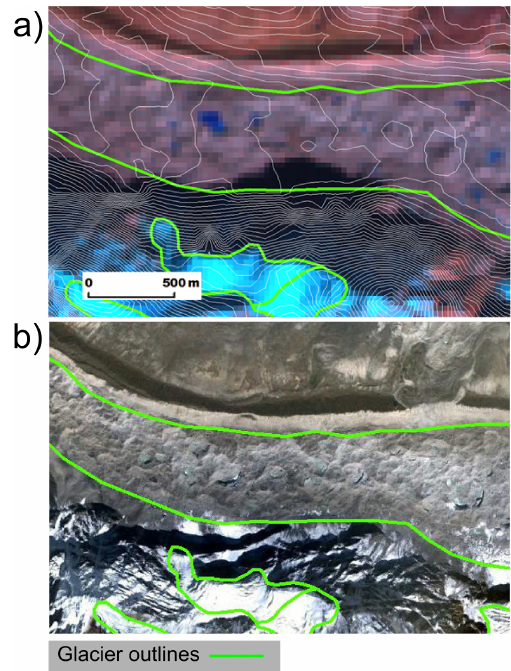
Figure 8. Example of glacier outlines generated with contour lines at path 140 row 41 of Landsat imagery (27.991 ◦ N, 86.730 ◦ E), taken on 30 October 2000 (a) , and Google Earth, © 2015 Digi- talGlobe screenshots of the same location (b) . When summertime (high solar angle) Landsat imagery lacking seasonal snow cover was unavailable, we employed wintertime (low solar angle) imagery. In that case, glacier outlines in shaded areas were delineated by refer- ence to slope-change boundaries indicated by contour intervals.